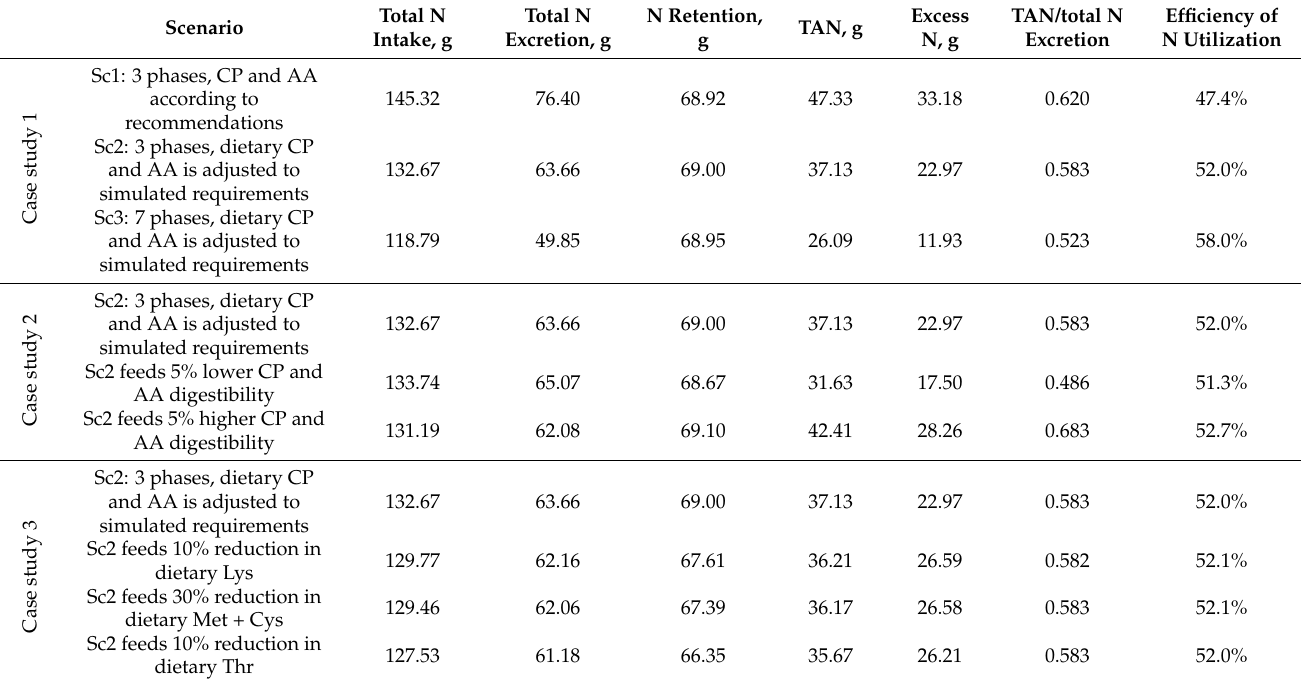
Table 3. Simulated performance in the case studies run with different